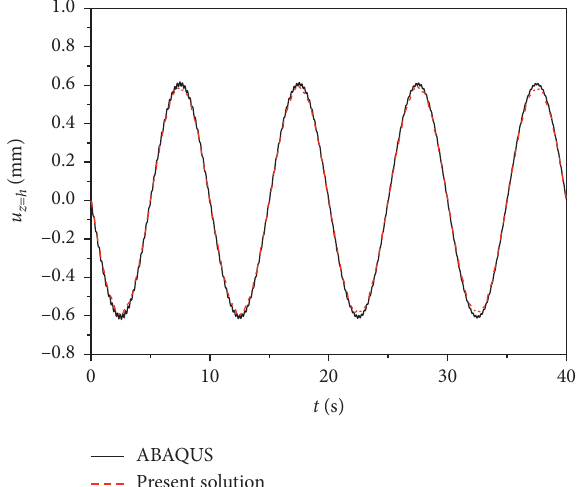
s / ω 0 with respect to σ 0 with